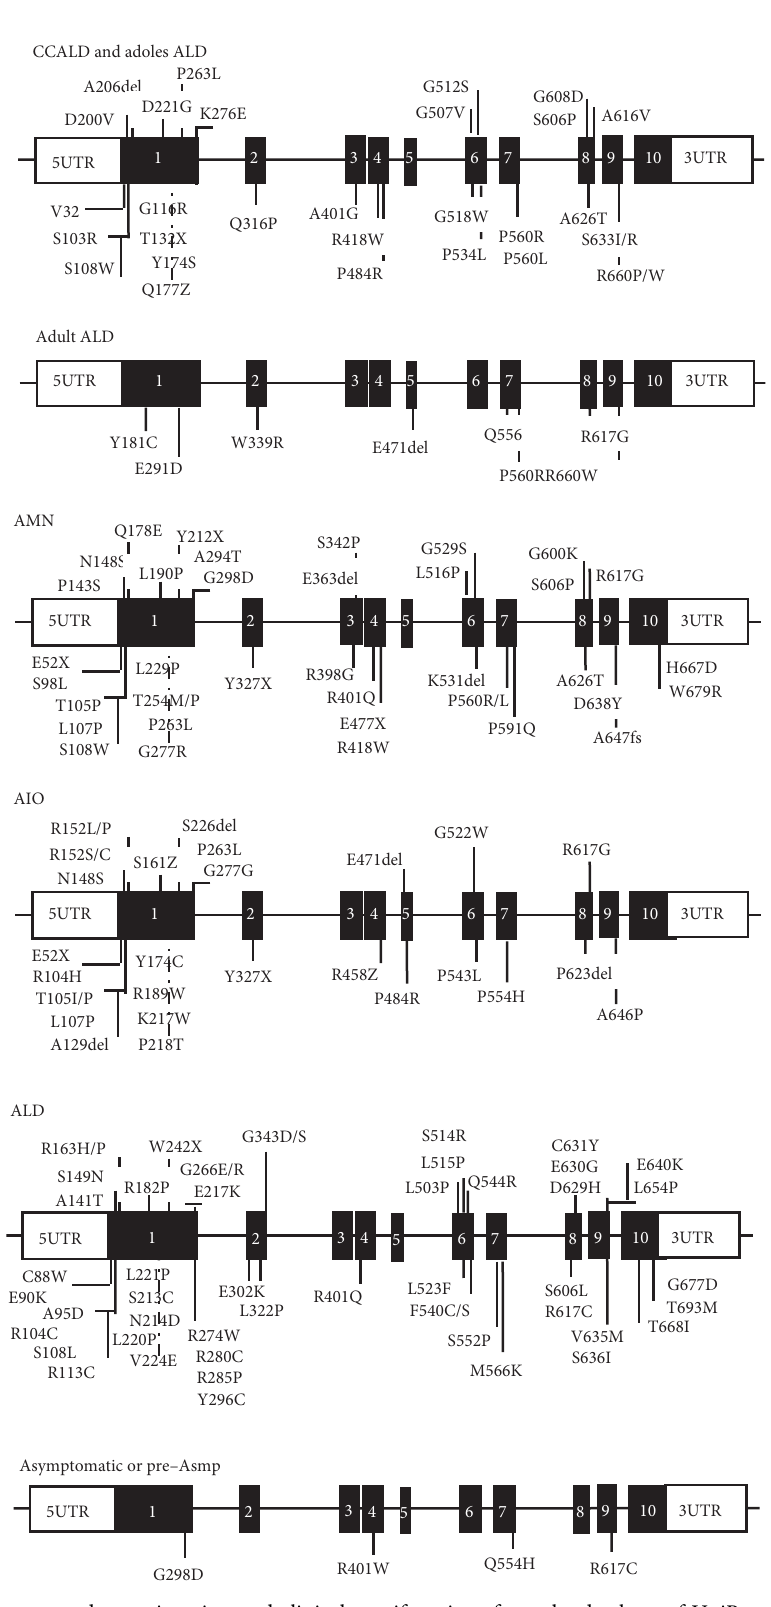
Figure 5: Summary of the reported mutation sites and clinical manifestations from the database of UniProt (https://www.uniprot.org/ uniprot/) and reported references [22–35]. The clinical types include childhood and adolescent cerebral ALD (CCALD and adoles ALD), adult ALD, AMN (adrenomyeloneuropathy), adrenal insufficiency-only (AIO), complicated ALD which cannot be classified, and asymptomatic or presymptomatic